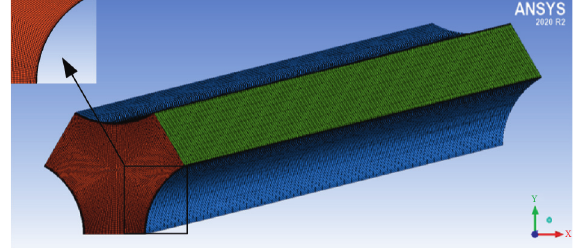
Figure 2: Mesh of the fluid